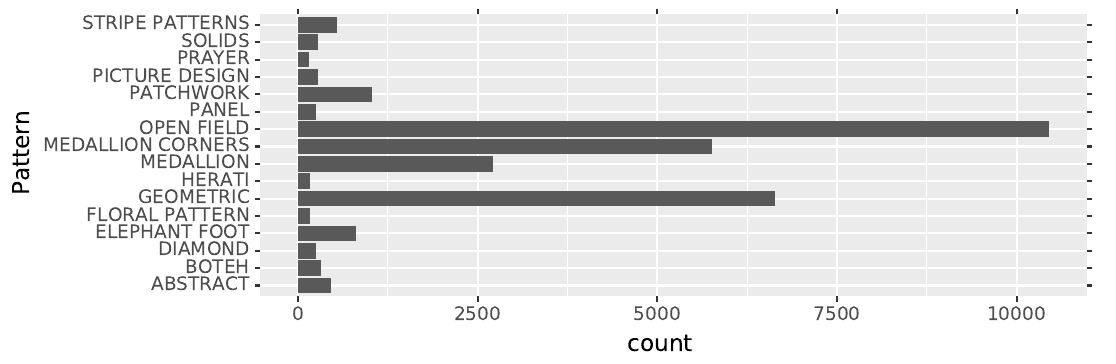
Figure 1. Frequency bar chart of pattern levels. Level names are sorted